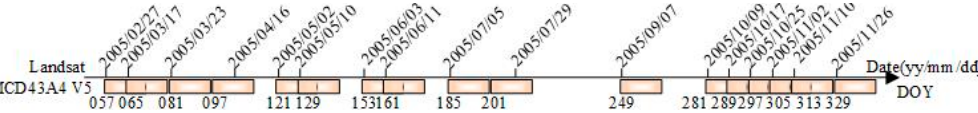
Figure 3. All available Landsat images with cloud coverage less than 70% from 2000 to 2016, where the LT5, LE7, and LC8 represent the Landsat 5 TM, the Landsat 7’s ETM+ sensor, and the Landsat 8 Table 2. Regression equation of spatiotemporal variance and R 2 . S_GS and ES_GS, respectively, OLI sensor, respectively. ( a ) Day of year (DOY) distribution of Landsat images, and ( b ) quantity represent Spatial and Temporal Adaptive Reflectance Fusion Model (STARFM) and Enhanced statistics of Landsat images in every year. STARFM (ESTARFM) in the growing season. S_NGS and ES_NGS represent STARFM and ESTARFM in the non-growing season, respectively.